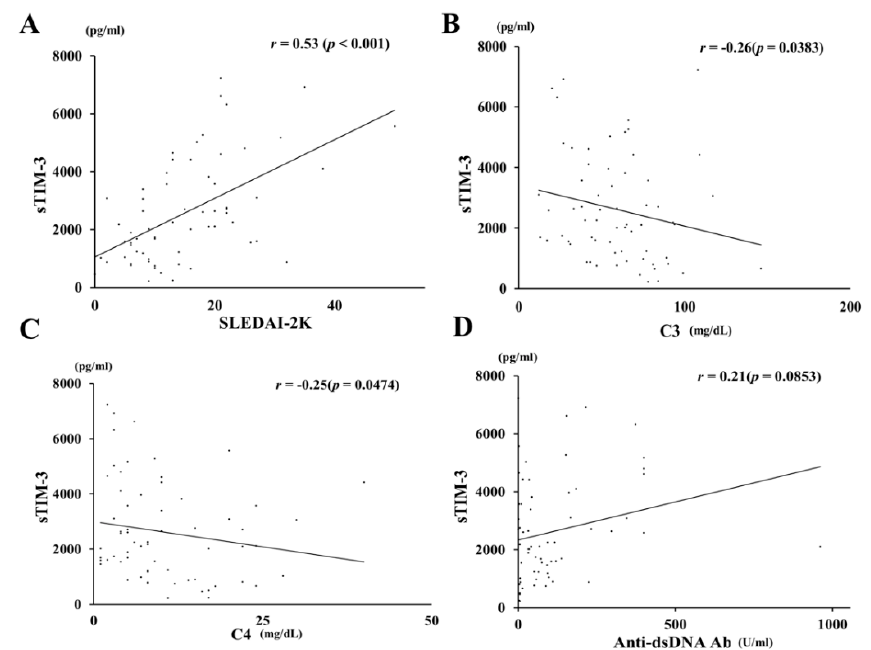
Figure 2. Correlations between serum sTIM-3 levels and clinical parameters in SLE patients. Serum sTIM-3 levels were significantly positively correlated with SLEDAI-2K ( A ) and negatively correlated with serum levels of C3 ( B ) and C4 ( C ). No significant correlation was observed between serum sTIM-3 levels and anti-double-stranded (ds) DNA antibodies ( D ). Statistics and regression lines are shown by solid lines. sTIM-3: soluble T-cell immunoglobulin and mucin-domain-containing molecule 3, SLEDAI-2K: Systemic Lupus Erythematosus Disease Activity Index 2000, C3: complement 3, C4: complement 4.